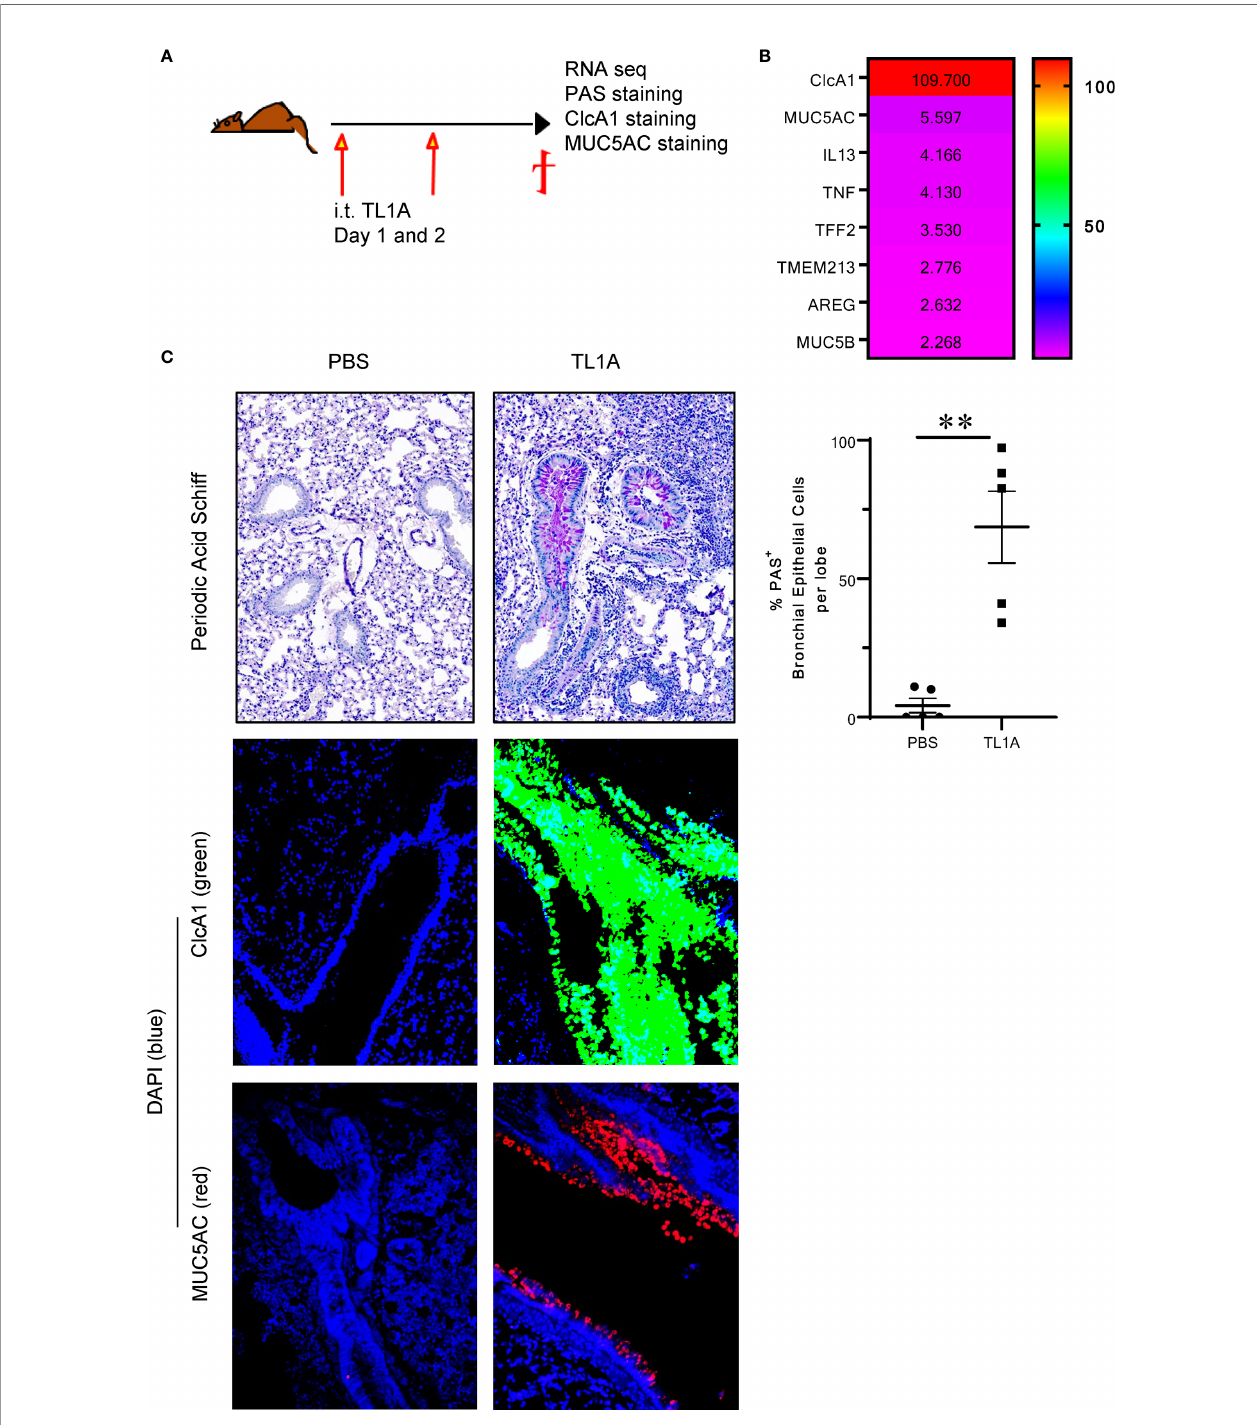
FIGURE 1 | TL1A induces mucus production when administered in isolation into the airways. (A) Schematic representation of the protocol used. Brie fl y, C57BL/6 mice were induced with 10 m g of recombinant TL1A i.t. on two successive days. Mice were euthanized 24h after the last i.t. injection, and lungs were harvested for RNAseq analysis, PAS, ClcA1 and MUC5AC stains. (B) Heatmap of the top differentially regulated genes involved in mucus production, upregulated in the lungs of TL1A-induced mice. (C) Top panel: PAS stain of mucus produced in the lungs and quanti fi ed using Image Pro Premier and graphed as %PAS+ bronchial epithelial cells per lobe (right panel). Mid and Lower panels: Immuno fl uorescence stains of CLcA1 (green), MUC5AC (red) and nuclear DAPI (blue). All results representative of three experiments with four to six mice per group. **p <